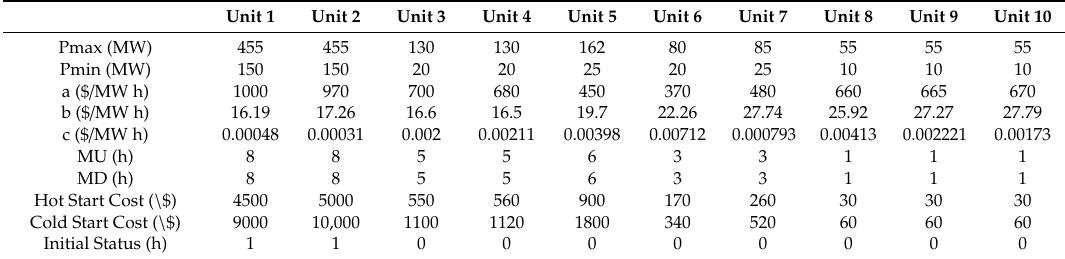
Table 1. Parameter setting for Binary Competitive Swarm Optimizer